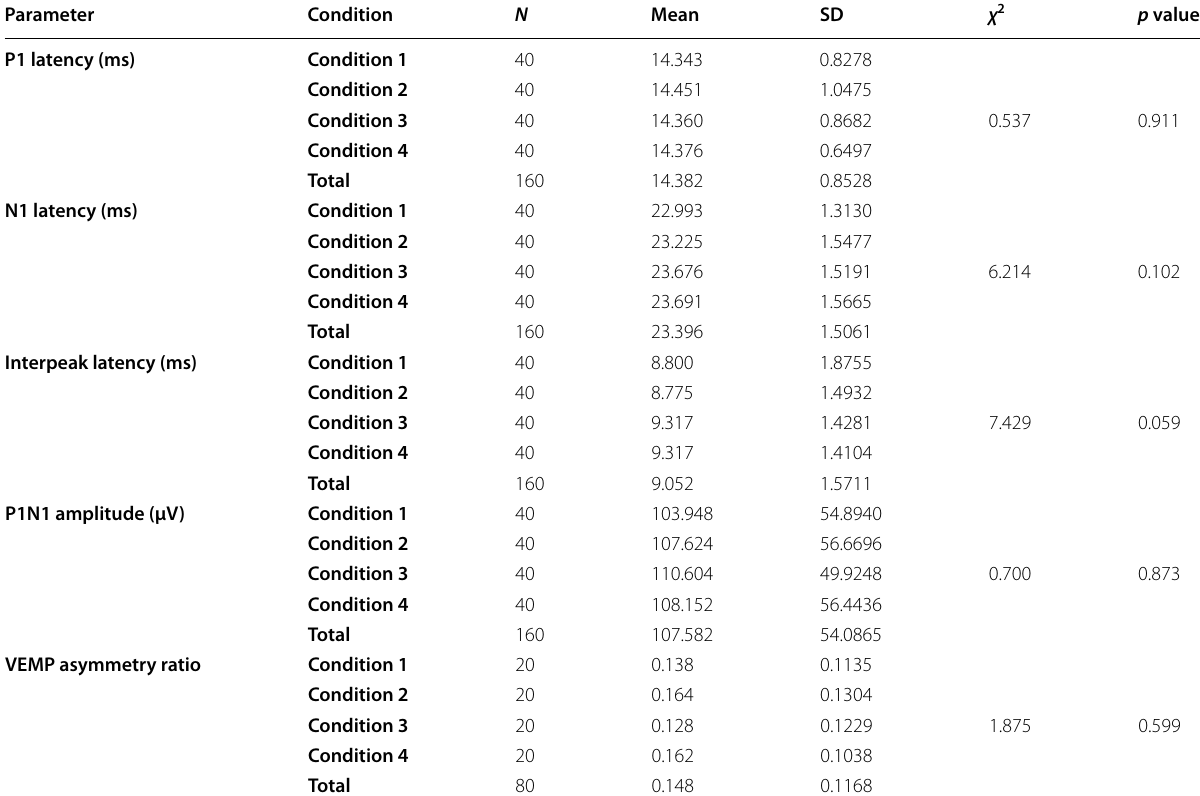
Table 2 Comparison of BC cVEMP parameters applied at 50 dB nHL intensity according to the occlusion conditions